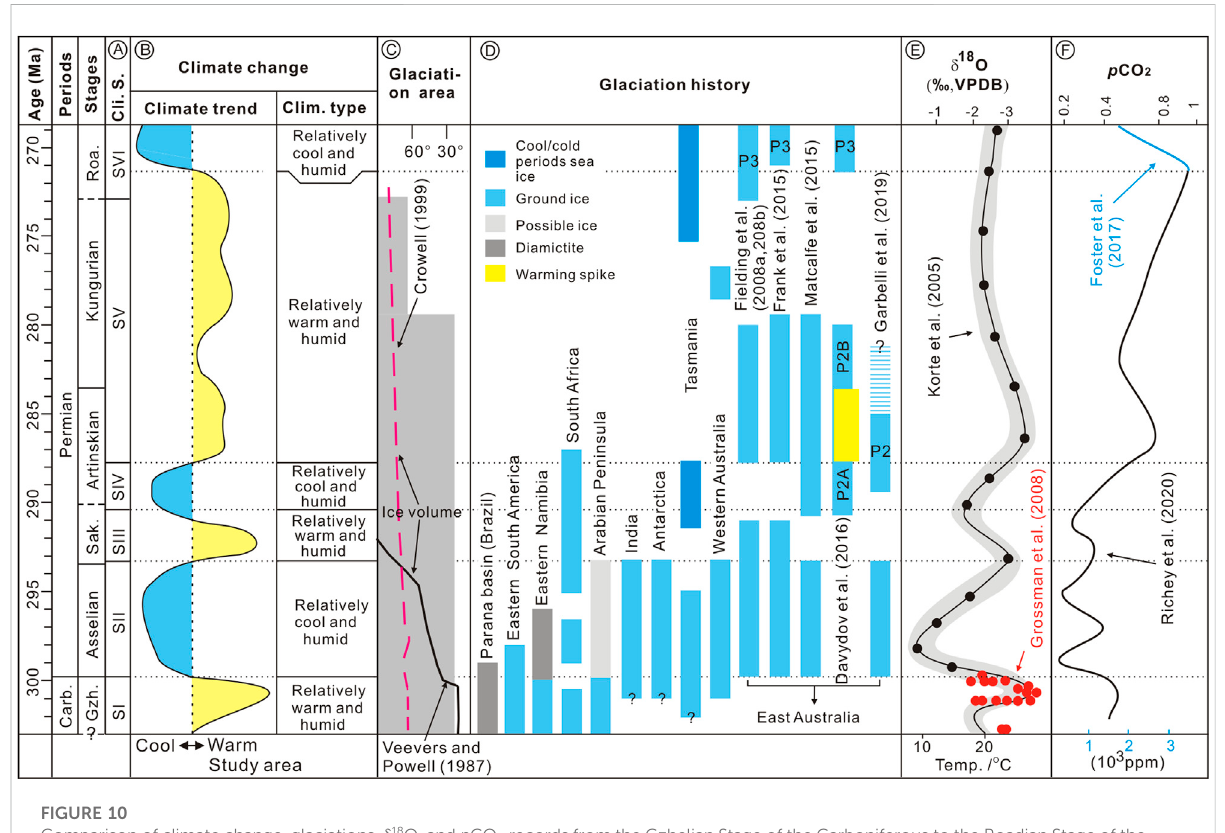
FIGURE 10 Comparison of climate change, glaciations, δ 18 O, and p CO 2 records from the Gzhelian Stage of the Carboniferous to the Roadian Stage of the Permian.Agestratigraphicframeworkfrom(Shenetal.,2019) (A) ,climatestagesinterpretedfromthestudiedsection (B) ,interpretedclimaticrecords with blue representing intervals of climate cooling, while yellow represents climatic warming based on fl uctuating climate signals from kaolinite content from the studied section and climate type interpreted from the studied section. (C) Glaciation area (modi fi ed after (Montañez and Poulsen,2013)and(Grif fi setal.,2018))superimposedonglaciationareaarerelativeice-volumecurvesthroughtimefrom(VeeversandPowell,1987) (black line)and(Crowell,1999)(redline). (D) Glaciationhistorymodi fi edfrom(Fielding etal.,2008a, 2008b,2008c;Franketal.,2008a,2008b,2015; Montañez and Poulsen, 2013; Metcalfe et al., 2015; Davydov et al., 2016; Grif fi s et al., 2018; Garbelli et al., 2019)). (E) Oxygen isotope values from (Korte et al., 2005; Grossman et al., 2008). (F) Global p CO 2 concentration from (Foster et al., 2017; Richey et al., 2020). Abbreviations: Gzh. = Gzhelian; Sak. = Sakmarian; Cli. S. = climate stage; Clim. type = climate type; S. hemi. (E. Aus.) = Southern hemisphere including Eastern Australia;